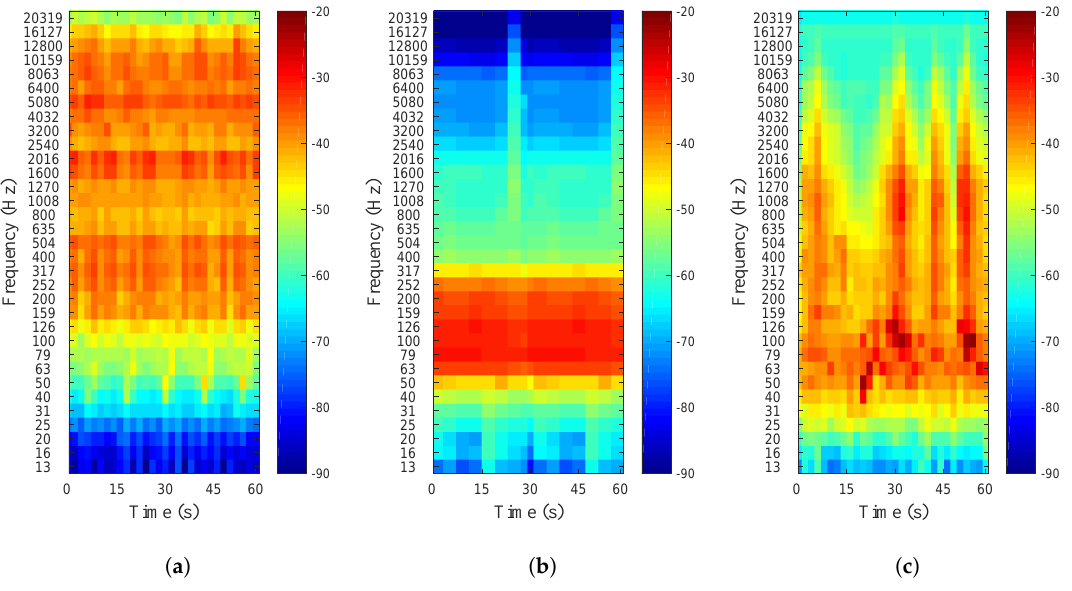
Figure 2. Spectrograms of the three maskers in one-third octave bands in dBFS: ( a ) Construction Work; ( b ) Car Engine; and ( c ) Heavy